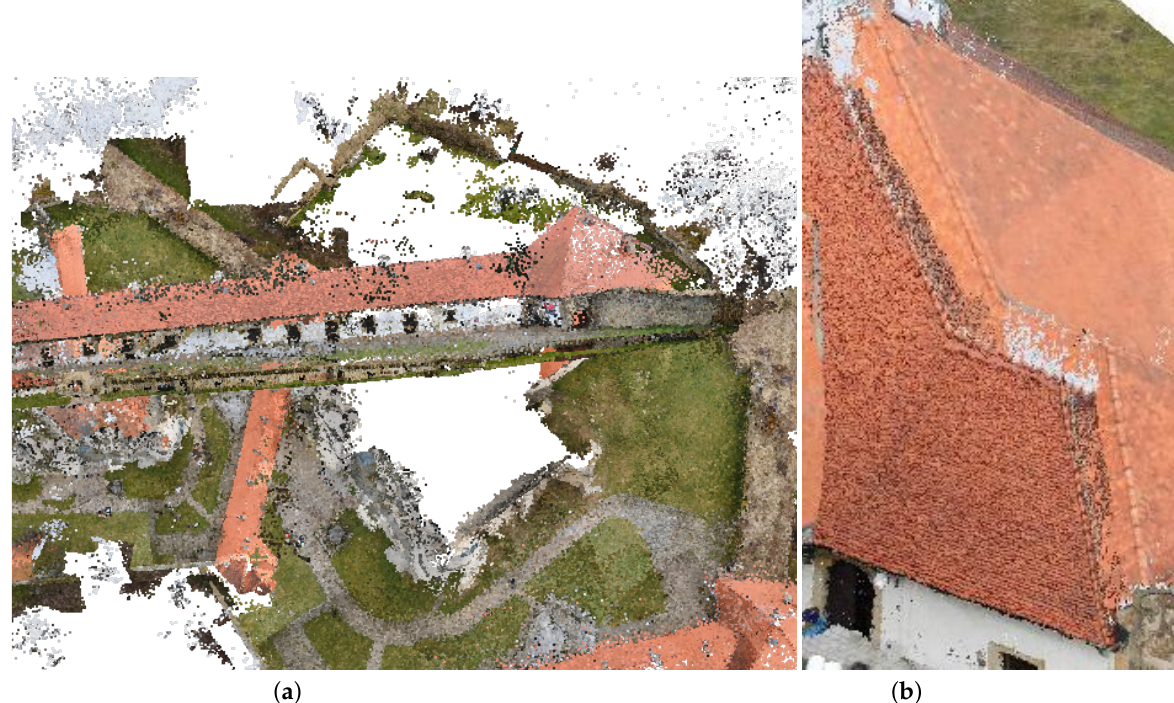
Figure 11. Matching errors: rough matching errors ( a ); precise adjustments ( b